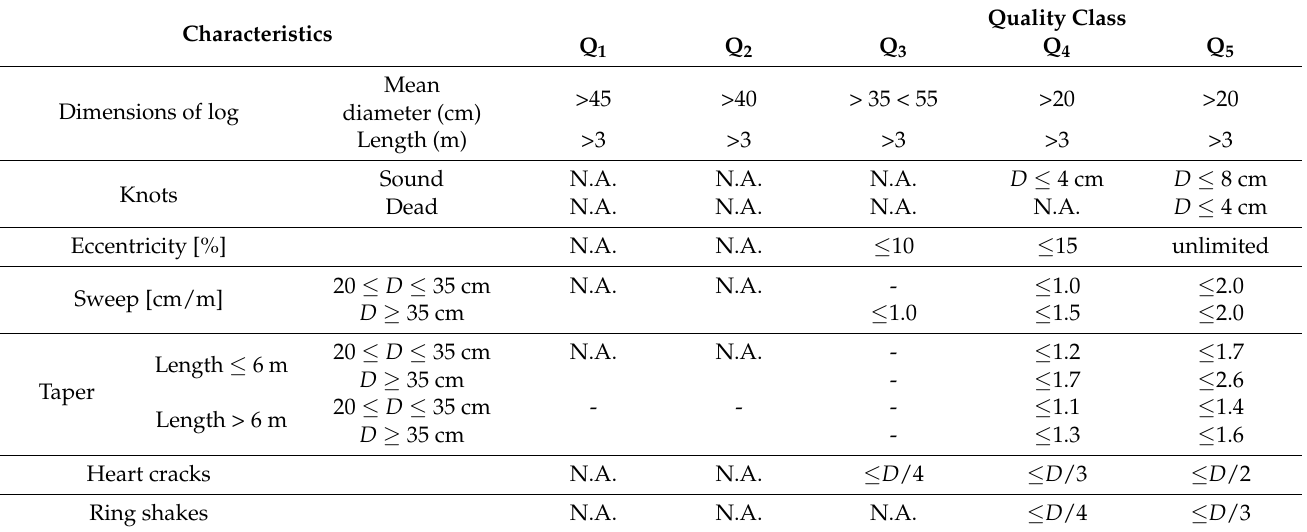
Table 1. Characteristics and threshold values for classifying logs into five quality classes according to the Slovenian regulations for the classification of forest timber assortments from state forests (Q 1 , Q 2 —exceptional, veneer quality logs; Q 3 –Q 5 —logs for sawn timber of excellent, medium, and poor quality; N.A.—not